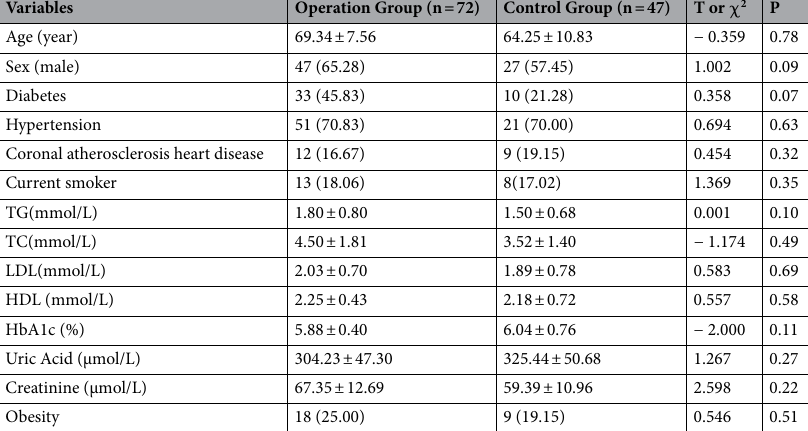
Table 1. Demographic data in the patients in the control and operation groups. HbA1c glycosylated hemoglobin; hypertension, systolic pressure ≥ 140 mmHg and diastolic pressure ≥ 90 mmHg, obesity body mass index ≥ 30 kg/m 2 . TG glycerin trilaurate, TC total cholesterol, LDL low density lipoprotein C, HDL high- density